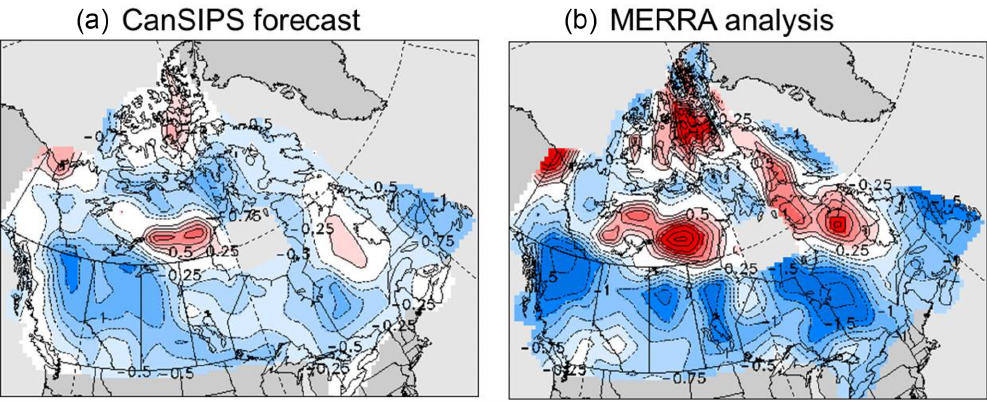
Figure 14. Real-time CanSIPS forecast of standardized anomalies of monthly-mean SWE for January 2016 (a) , initialized at the end of the preceding month, compared to the MERRA analysis for the same period (b) . The contour interval is 0.25, and anomalies are relative to a 1981–2010 base period.